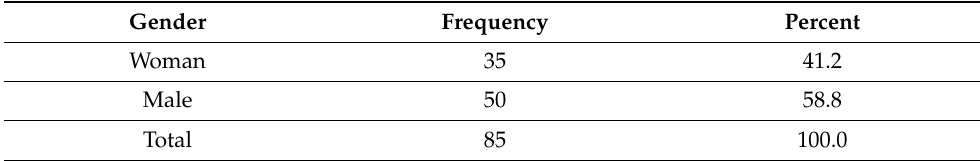
Table 4. Gender distribution of individuals with ASD who received